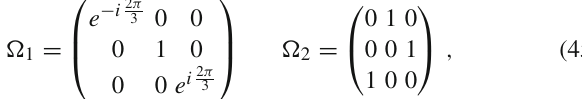
Fig. 2 Same as Fig. 1 with data drawn as a function of the number of configurations included in the analysis. Each colour corresponds to a different momentum. Horizontal lines are the analytical